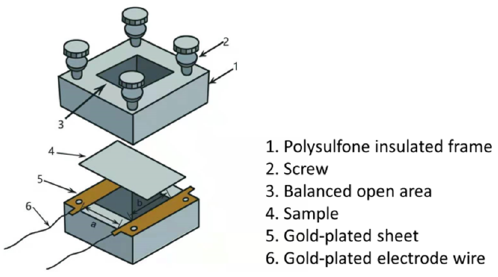
Figure 1. Impedance measuring system.